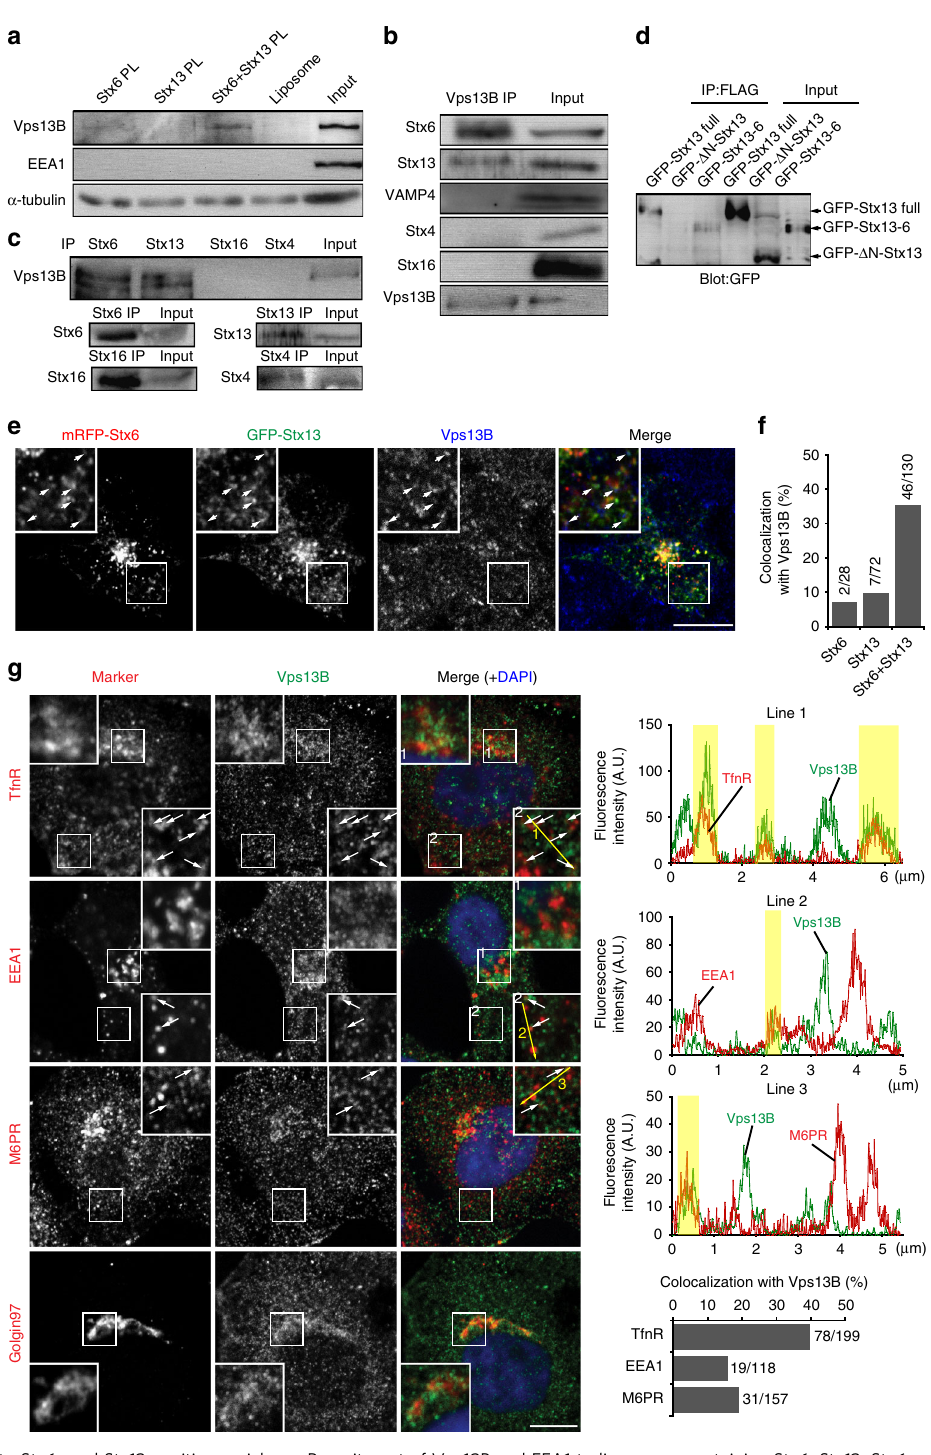
Fig. 5 Vps13B binds to Stx6- and Stx13-positive vesicles. a Recruitment of Vps13B and EEA1 to liposomes containing Stx6, Stx13, Stx6, and Stx13 together. For details, see legend to Fig. 4b. α -Tubulin was used as loading control, because the protein binds to liposomes dependent on the lipid composition (ref. 23 ). b , c Co-immunoprecipitation of Vps13B and SNARE proteins; b shows co-precipitation of Stx6 and 13 but not of any other SNARE with Vps13B. c Conversely, Vps13B co-precipitates with Stx6 and Stx13 but not with Stx16 and Stx4. The bottom panel shows that all SNAREs were ef fi ciently immunoprecipitated. d The N- terminal domain of Stx13 is necessary for binding to Vps13B. Lysates from cells expressing Vps13B-FLAG and GFP-Stx13, GFP- Δ N-Stx13, or GFP-Stx13-Stx6 chimera were immunoprecipitated with anti-FLAG antibody and probed by immunoblotting for GFP. e Immuno fl uorescence for Vps13B of cells expressing mRFP-Stx6 and GFP-Stx13. Arrows in the insert indicate triple-positive vesicles. Scale bar, 10 µ m. f Co-localization between Stx6, Stx13, and Vps13B in the peripheral region of the imaged HeLa cells. Vesicles were counted from nine images, obtained in three independent experiments, with the degree of overlap shown in the bar graph on the right (numbers denote total number of vesicles analyzed). g Co-localization of Vps13B with TfnR, EEA1, M6PR, and Golgin97. White arrows show co-localized vesicles. Scale bar, 10 µ m. Intensity plots of exemplary line scans are shown on the right. A bar graph shows the percentage of TfnR-, EEA1-, M6PR-positive vesicles, which are also positive for Vps13B NATURE COMMUNICATIONS| (2019) 10:1608